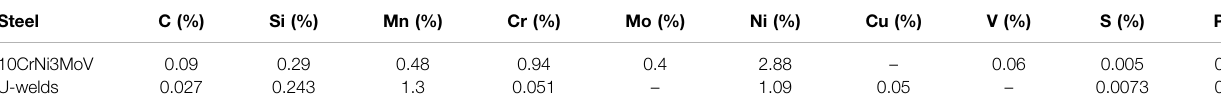
TABLE 1 | Nominal chemical composition of the base metal and the undermatched weldments.